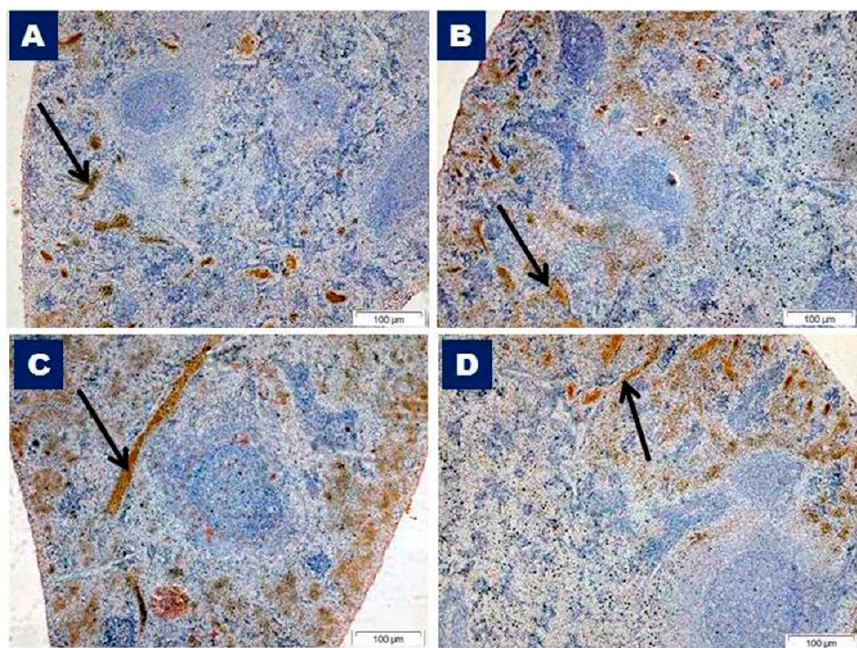
Figure 7. Photomicrographs of immunohistochemically-stained sections of the spleen with anti- tumor necrosis factor alpha (TNF- α ) from different studied groups. ( A ) Splenic section from the control group showing negatively stained white pulp, with positive brown staining in the red pulp (arrow). ( B ) Splenic section from the vitamin C group showing a positive brown reaction in the red pulp (arrow) and no immunostain in the white pulp. ( C ) Splenic section of the Olanzapine-treated group showing increased immunoreactivity in the red pulp (arrow) with negatively stained white pulp. ( D ) Splenic section from the Olanzapine and vitamin C group showing moderate staining in the red pulp (arrow) and negatively stained white pulp. TNF- α immunostaining, ×100.